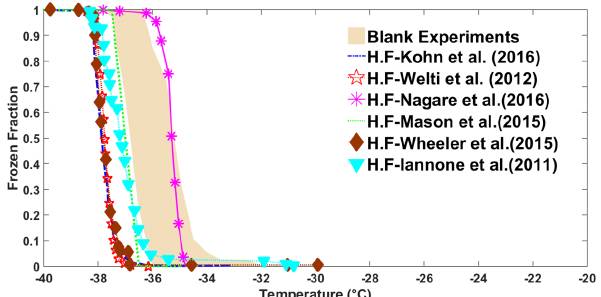
Figure 4. Activation curve for the blank experiments (rose shaded area) obtained with the UNAM-DFT using pure water. Colored lines correspond to homogeneous freezing (H.F.) curve literature data. Dashed blue line: Kohn et al. (2016); red stars: Welti et al. (2012); magenta asterisks: Nagare et al. (2016); dotted green line: Mason et al. (2015a); brown diamonds: Wheeler et al. (2015); and cyan triangles: Iannone et al.